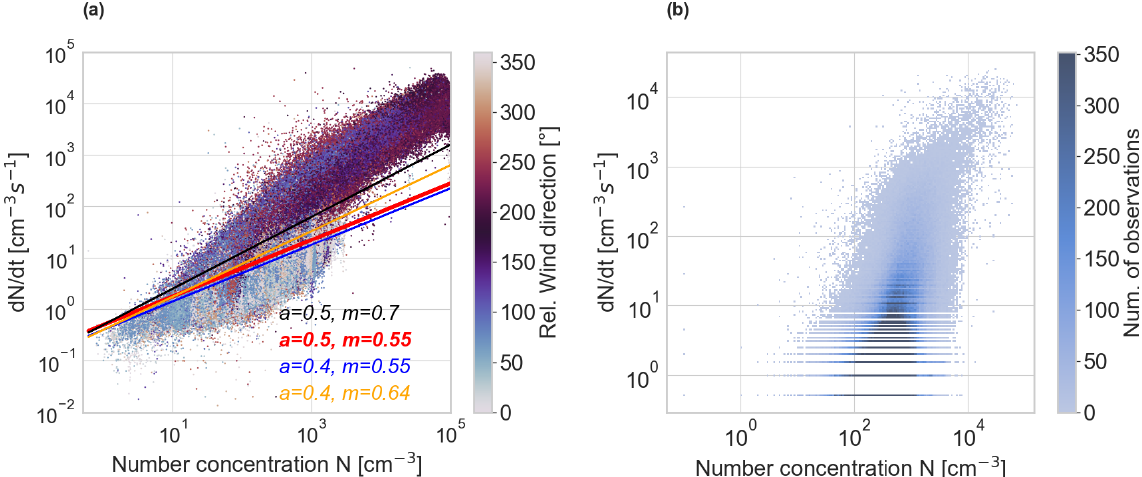
Figure 3. Absolute value of the minute-averaged particle number concentration derivative as a function of the minute-averaged particle number concentration. (a) The dataset collected during the MOSAiC expedition. The color code indicates the relative wind direction. The four lines show potential separation lines between polluted and unaffected data points for four different combinations of slope and intercept ( y = a × x m ). Here we used the red line. (b) The binned dataset collected at Jungfraujoch station in the Swiss Alps in 2016 (Bukowiecki et al., 2021). The color code indicates the number of observations per